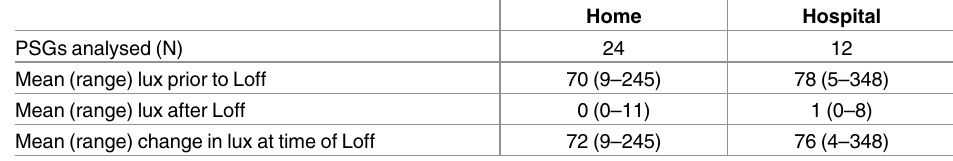
Table 2. Light intensity values prior to and after lights off (Loff) in home and hospital polysomnogra- phy (PSG).